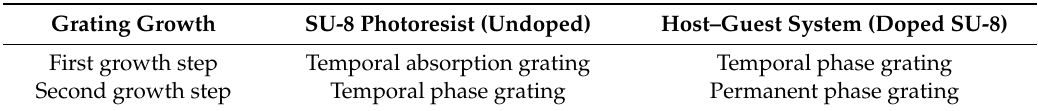
Table 1. Overview on types of volume holographic gratings, assumedly causing first and second growth step in case of doped and undoped SU-8, respectively.